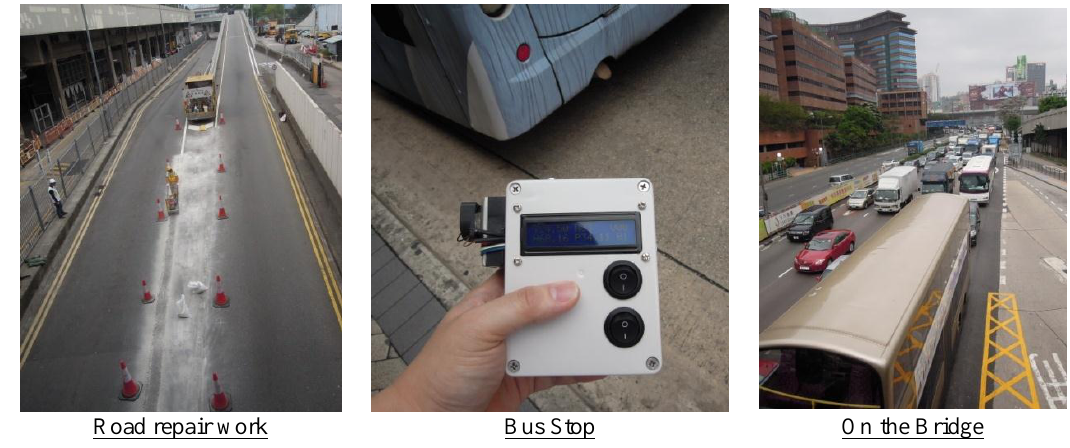
Road repair work Bus Stop On the